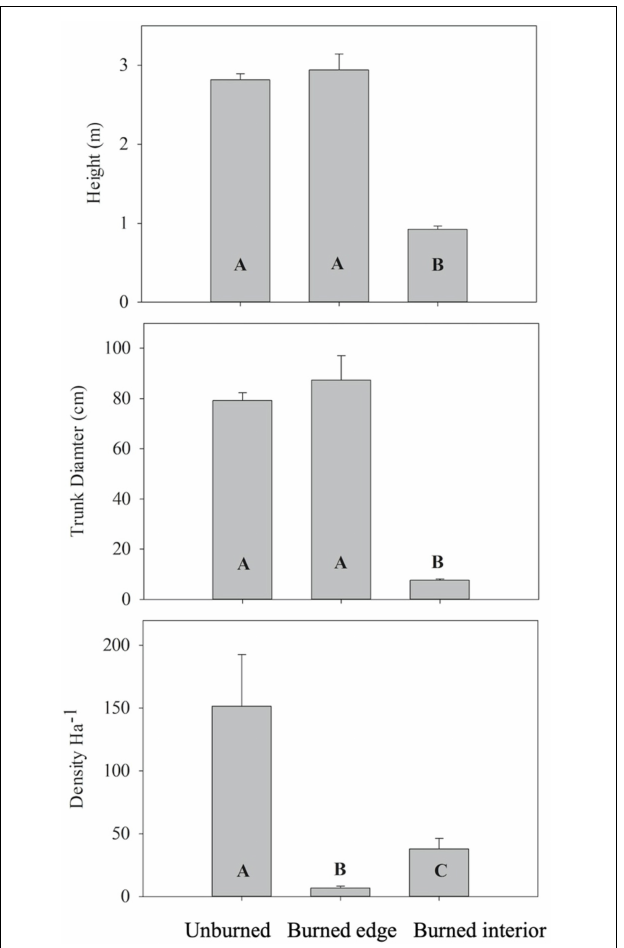
FIGURE 2 | Height, trunk diameter and stand density of living Joshua trees (means ± SE) along unburned, burned edge and burned interior transects. Different letters denote statistically significant difference in mean values ( P < 0.05) between different burn conditions using Tukey’s HSD. N = 6 for unburned and burned edges, N = 5 for burned